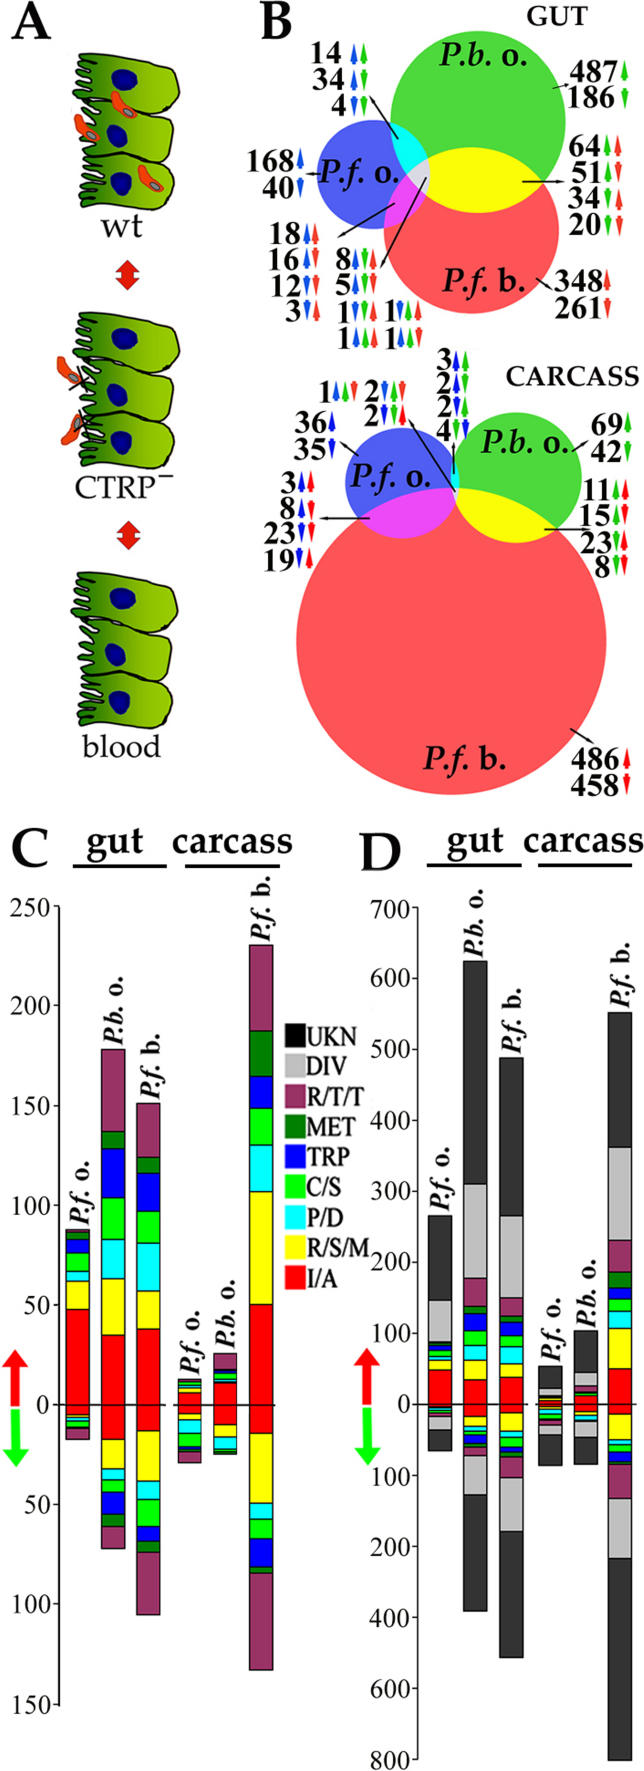
Experimental Design and Global Gene Expression Patterns at the Different Conditions of Infection(A) Model outlining the experimental design for assessing responses to the invading ookinetes (indicated as P.f. ookinete [P.f. o.] and P.b. ookinete [P.b. o.] in (B) and (C) by comparing transcription between mosquitoes fed on blood infected with a wt Plasmodium strain and those fed on blood infected with the invasion-incapable mutant Plasmodium strain CTRP−. Responses to infected blood (indicated as P.f. blood in [B] and [C]) in the absence of ookinete invasion were assessed by comparing gene expression between mosquitoes fed on blood infected with the P. falciparum invasion-incapable mutant and mosquitoes fed on noninfected (no Plasmodium) blood.(B) Gene regulation in midgut and carcass tissues triggered by P. falciparum ookinete invasion (P.f. ookinete), P. berghei ookinete invasion (P.b. ookinete), and P. falciparum strain CTRP−-infected blood lacking invasive ookinetes (P.f. blood). Colored arrows indicate genes that are up- or down-regulated in the various unique and overlapping sections.(C) Proportions and numbers of genes belonging to distinct functional classes which were up- or down-regulated by the various stimuli in the gut and carcass tissues. DIV: diverse; R/T/T: replication, transcription, translation; MET: metabolism; TRP: transport; CY/ST: cytoskeletal, structural; PR/DI: proteolysis, digestion; MIT: mitochondrial; RE/ST: oxidoreductive, stress-related; APO: apoptosis; P/A: putative immunity and apoptosis. Gene functions were predicted based on Gene Ontology data and manual sequence homology searches.(D) Same as in (C), but also including genes of diverse functions (DIV) and unknown functions (UKN).